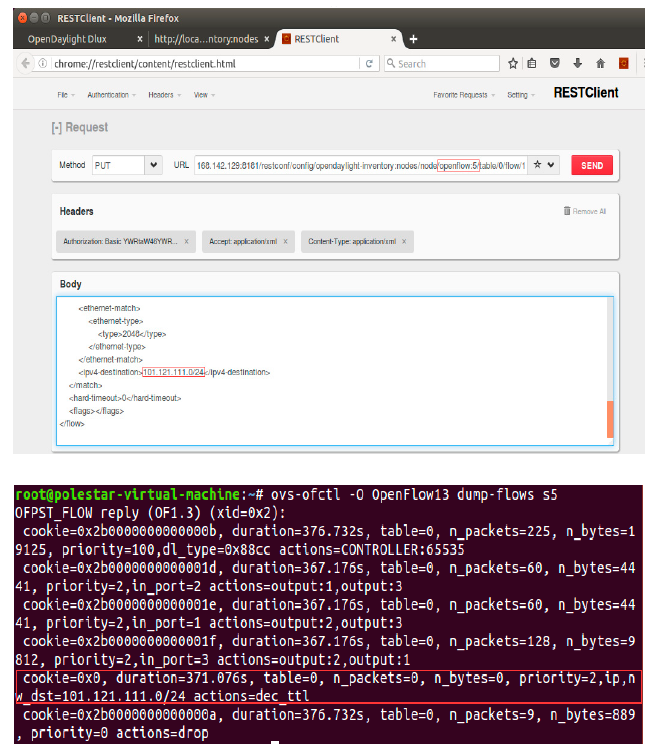
Figure 4. The result of flow table delivery.